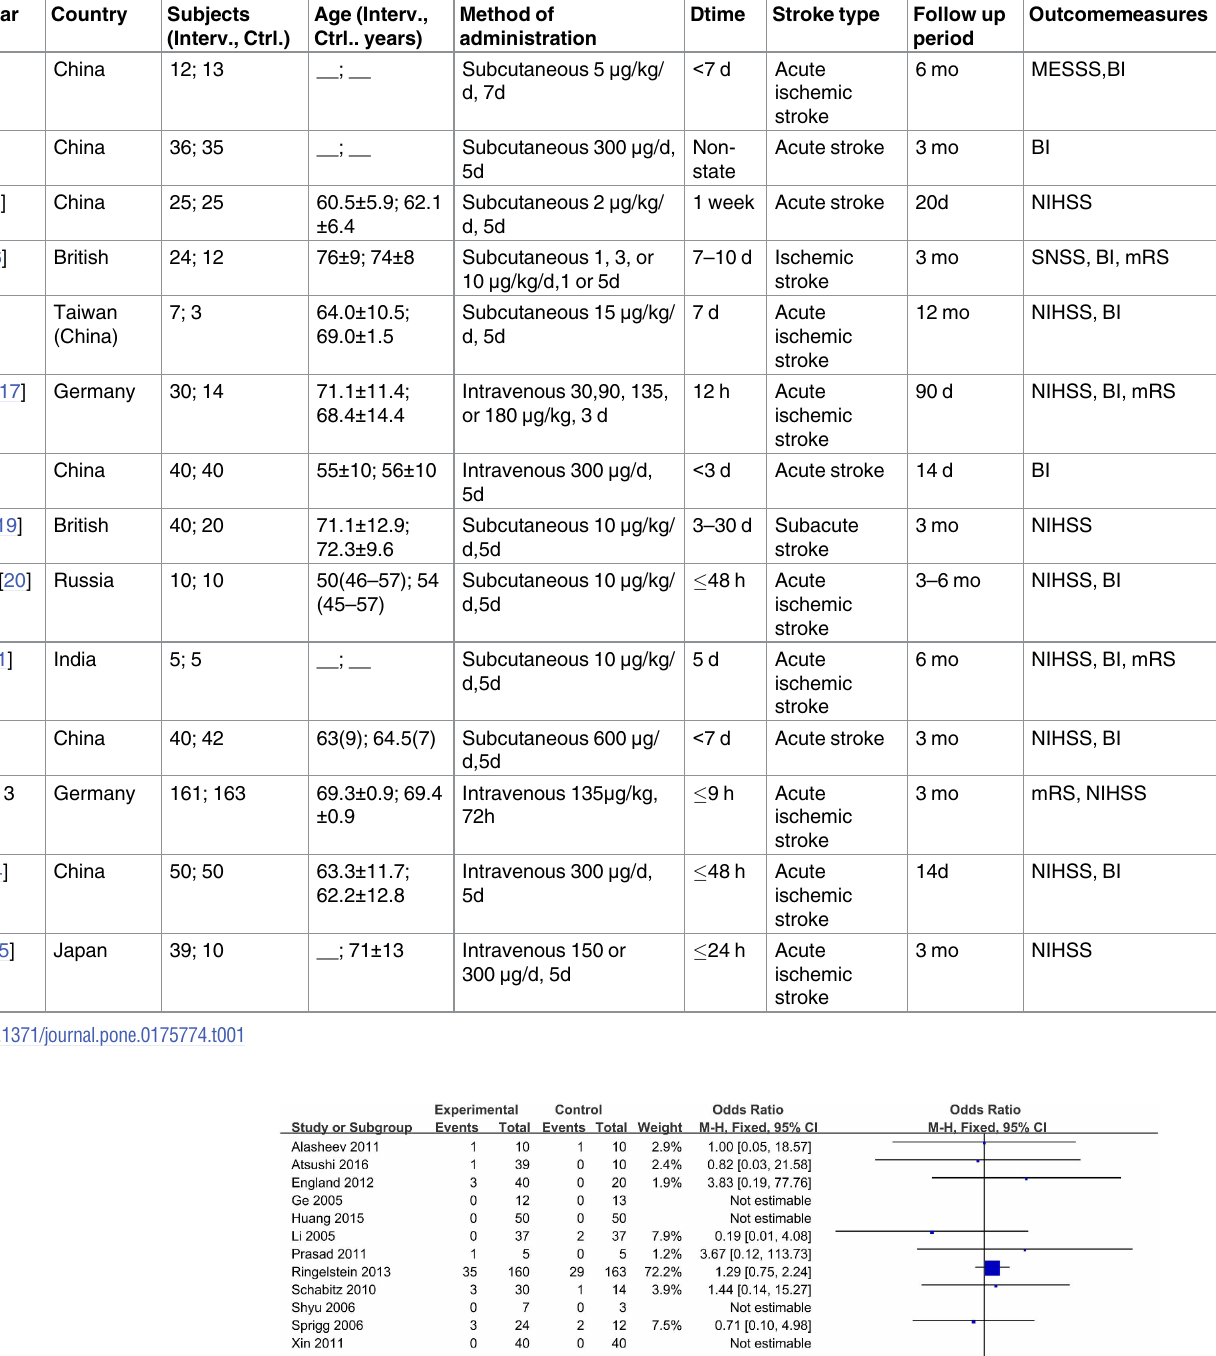
Table 1. Characteristics of included